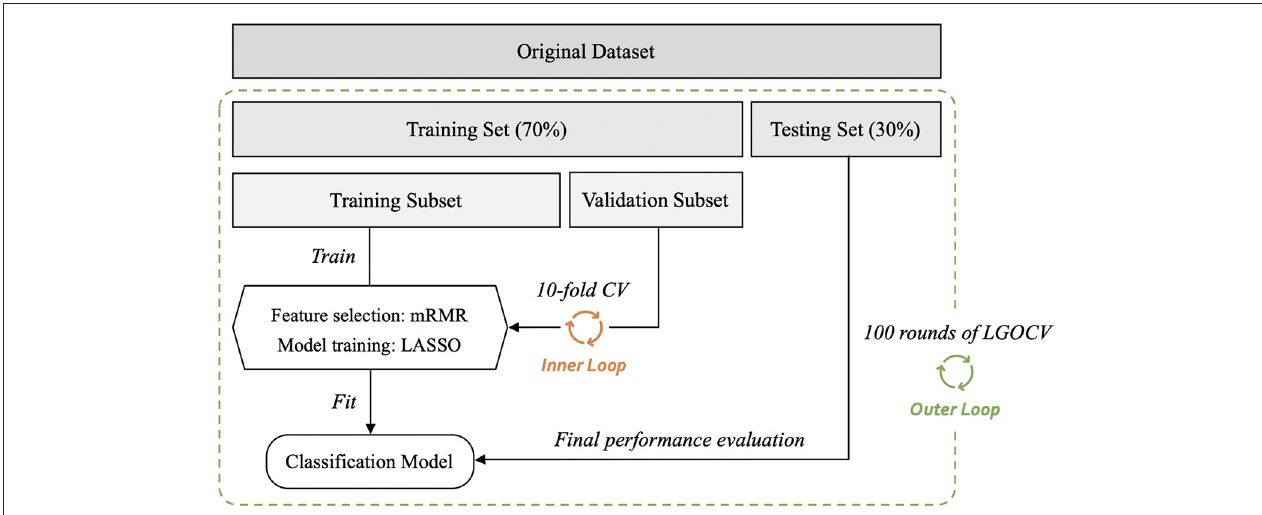
FIGURE 5 | General structure of the radiomics-based classification model. After 100 rounds of leave-group-out cross-validation (LGOCV), the mean values of the area under the receiver operating characteristic curve, sensitivity, and specificity of the models were generated. mRMR, maximum relevance minimum redundancy; CV,